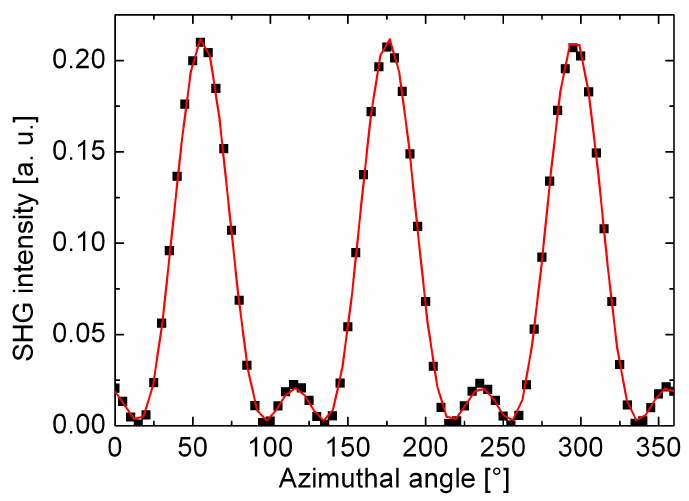
Figure 8. Azimuthal dependence of the second harmonic intensity of a (111) oriented silicon surface measured in reflection. The fundamental and second harmonic beams are p-polarized. The dots represent measured values. The solid line is a least square fit of Equation 17 to the measurement.